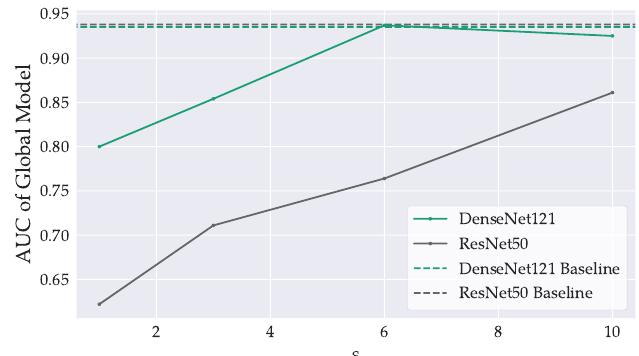
Figure 6. Model performance, evaluated on the clients’ test sets in dependence on the privacy budget ε . Baselines mark the peak performance of global non-private models. Stronger privacy guarantees degraded model